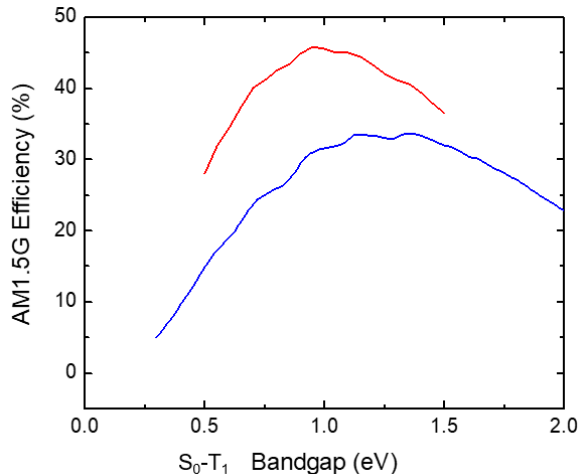
Figure 1. Maximum theoretical efficiency of a single-junction solar cell, assuming 1 sun illumination, full absorption of incident solar light above 1.1 eV, detailed balance, 200% triplet yield in the singlet fission layer, and production of an electron-hole pair from each tri- plet. Bottom curve (blue): ordinary; top curve (red): top layer, sin- glet fission and bottom layer, ordinary. Reproduced by permission from Hanna and Nozik.